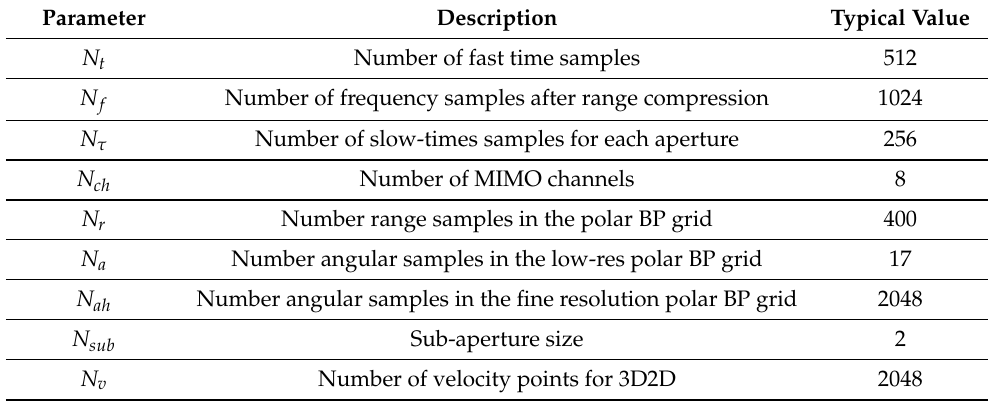
Table 4. List of the parameters involved in the calculation of the total number of operations requested to form an SAR